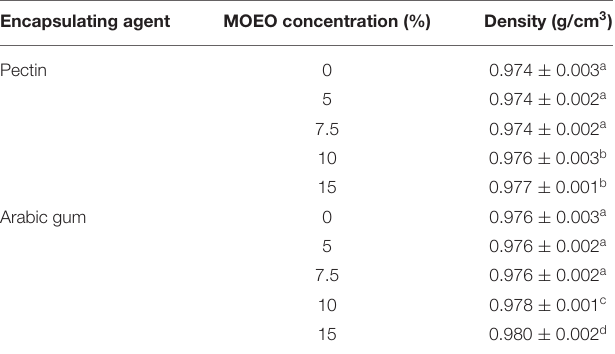
TABLE 2 | Density of the different emulsion systems using pectin or Arabic gum as encapsulating agents at different Mexican oregano essential oil (MOEO)